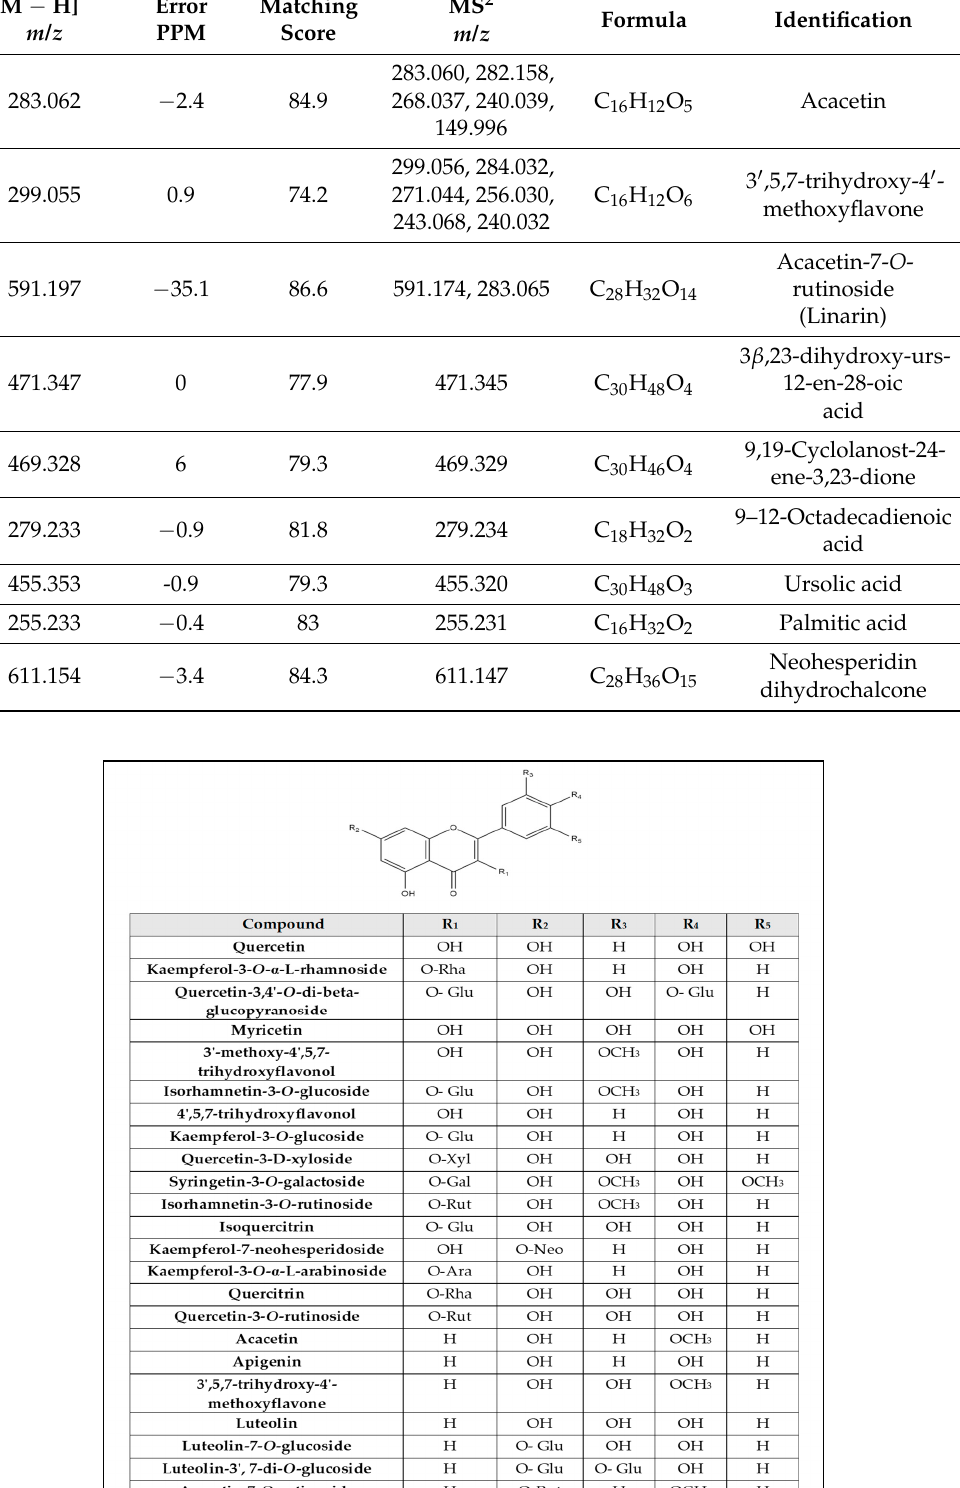
Figure 2. Structures of fl avanones and their glycosides.